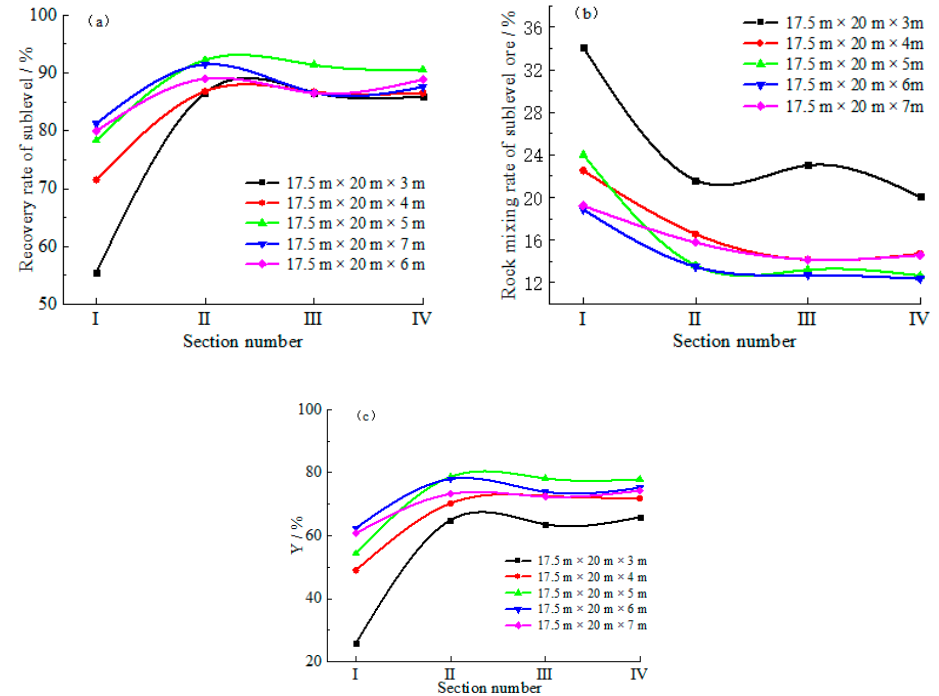
Figure 16. Curves of the recovery indexes of sublevel ore in each structural parameter scheme: ( a ) recovery ratio curve of sublevel ore; ( b ) rock mixing ratio curve of sublevel ore; ( c ) curve of the difference between recovery and dilution ratio of sublevel ore.